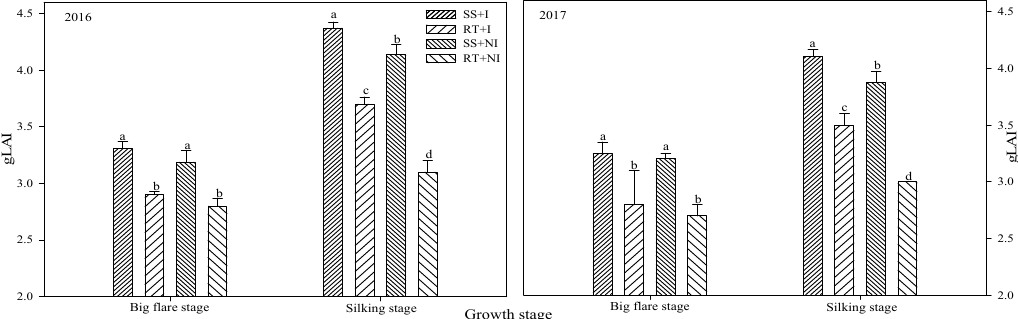
Figure 1. E ff ects of di ff erent tillage practices on the green leaf area index (gLAI) in maize. Di ff erent Figure 1. Effects of different tillage practices on the green leaf area index (gLAI) in maize. Different small letters in the same growing stage indicate significant di ff erences between tillage practices. small letters in the same growing stage indicate significant differences between tillage practices.